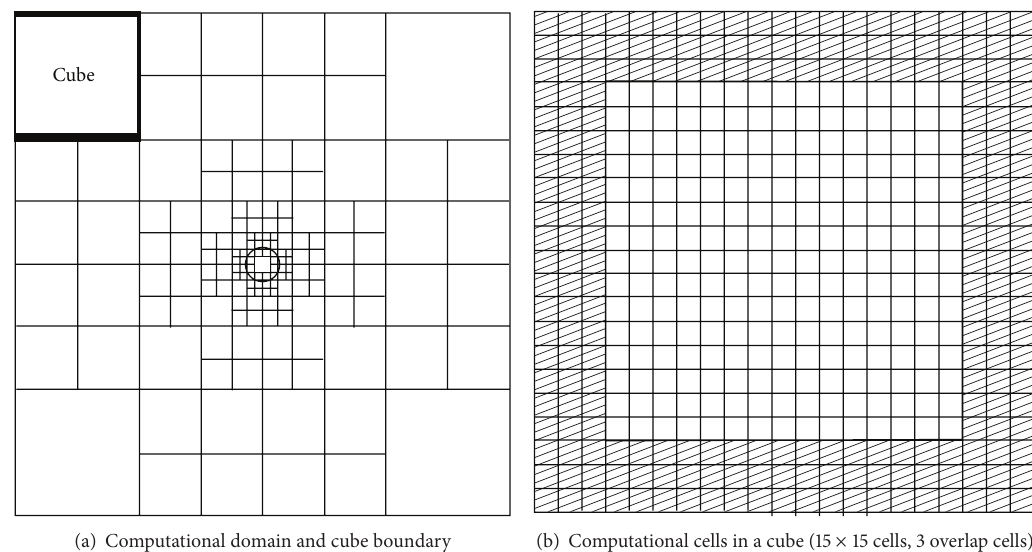
Figure 1: Computational mesh of the building-cube method (BCM) in two